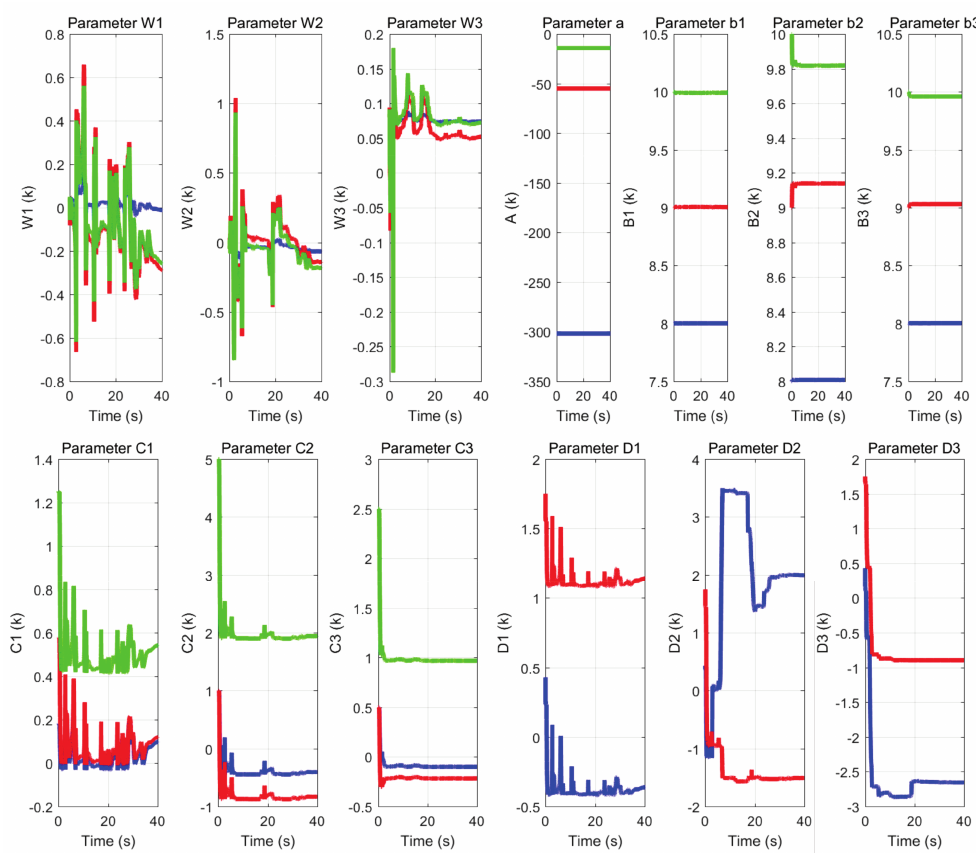
Figure 34. Behavior of neural network parameters used in the labyrinth of exercise 2. Figures 35 and 36 corresponds to the behavior of the PID gains, auto-tuned online for each degree of freedom of the device.